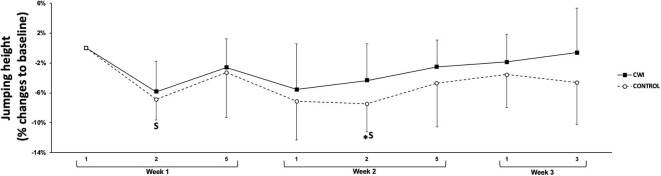
Figure represents countermovement jump height changes to baseline ± SD across time points for CWI and Control groups. *Significant difference (p < 0.05) from baseline in the Control group. Effect size (d) for between group comparison: S, Small.